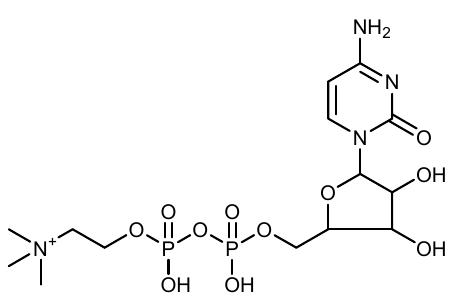
Figure 1. Chemical structure of citicoline [cytidine 5-diphosphocholine].